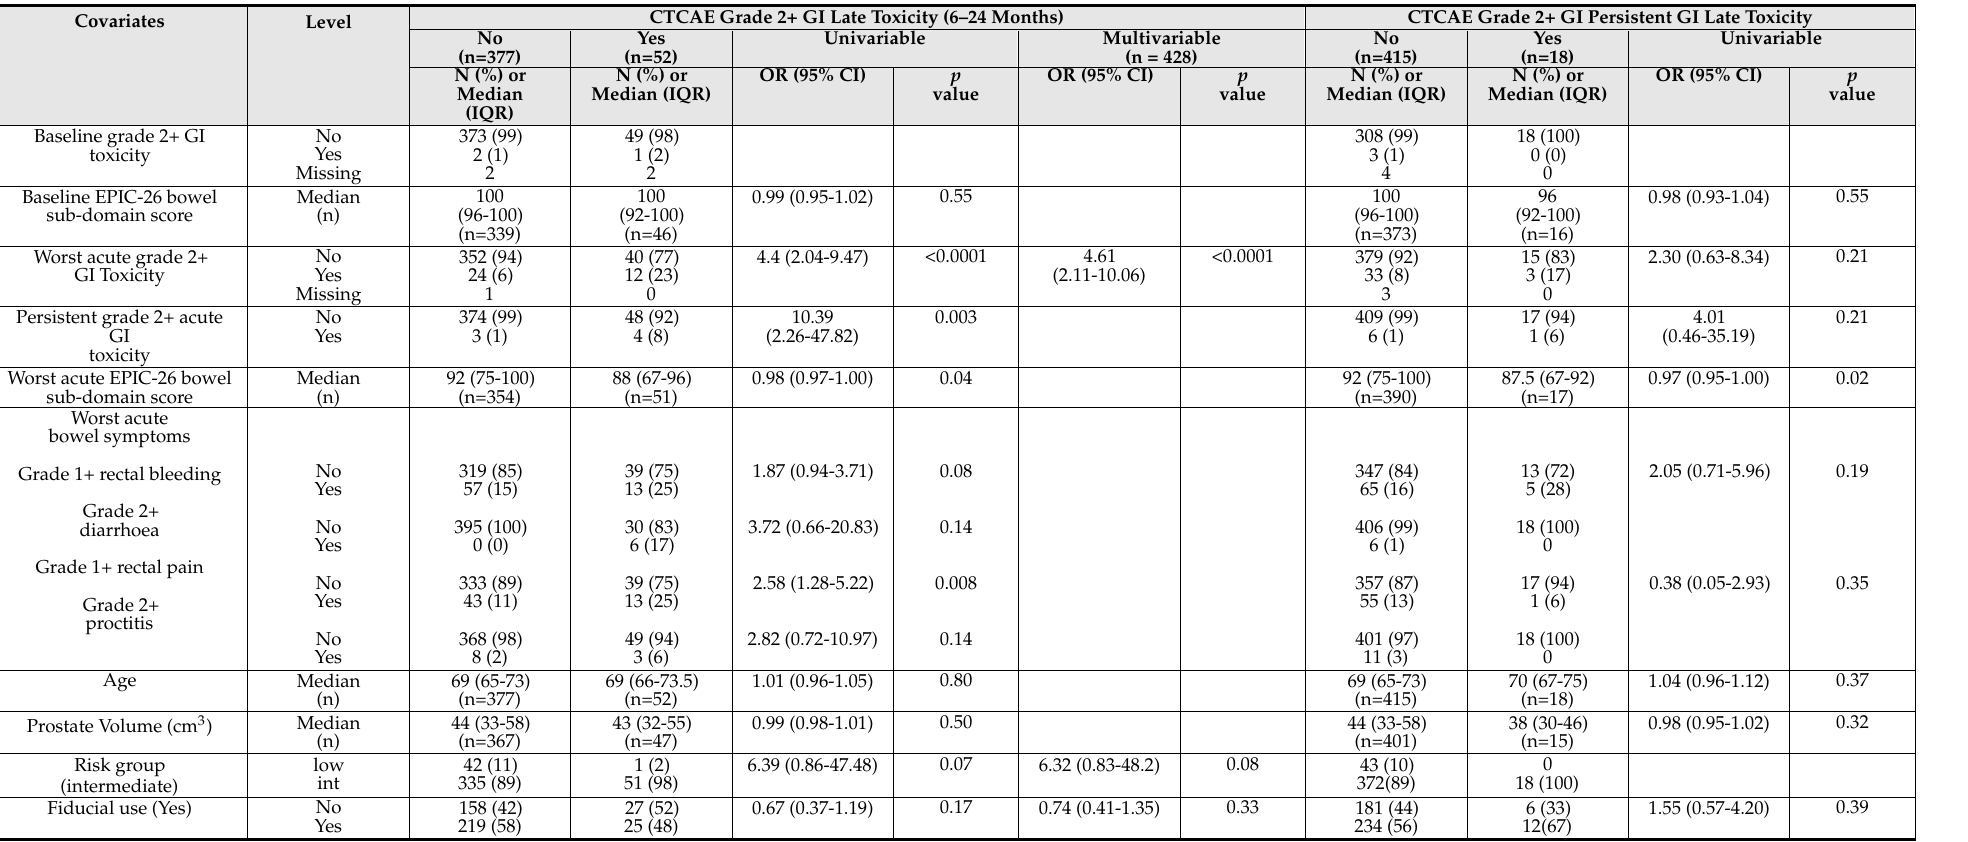
Table 5. Univariable and multivariable logistic regression model to identify covariates associated with late CTCAE gastrointestinal toxicity after